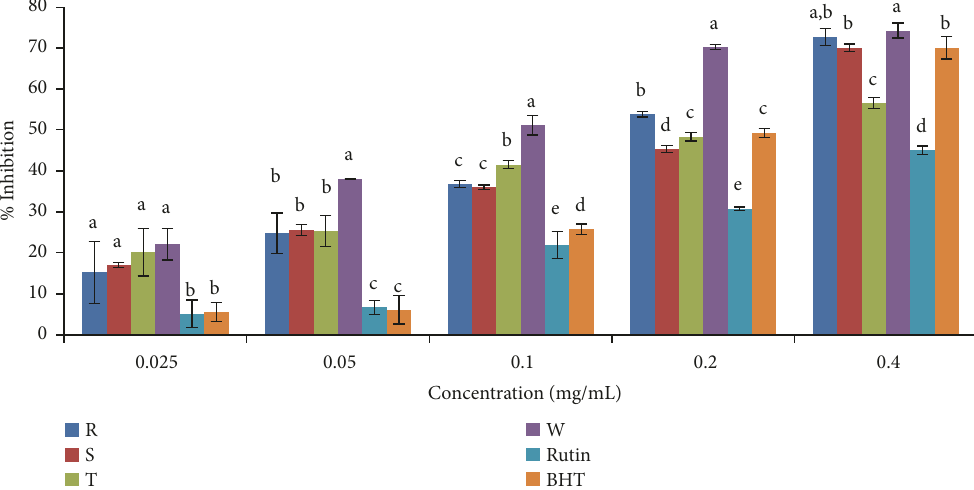
Figure 6: NO scavenging activity of ethanolic extract of the four varieties of Capsicum species.. Values are mean ± SD of three replications. Set of bars having different letters are significantly different at (p < 0.05). R= C. annuum var. abbreviatum , S= C. annuum var. acuminatum , T= C. annuum var. grossum , and W= C. frutescens var .